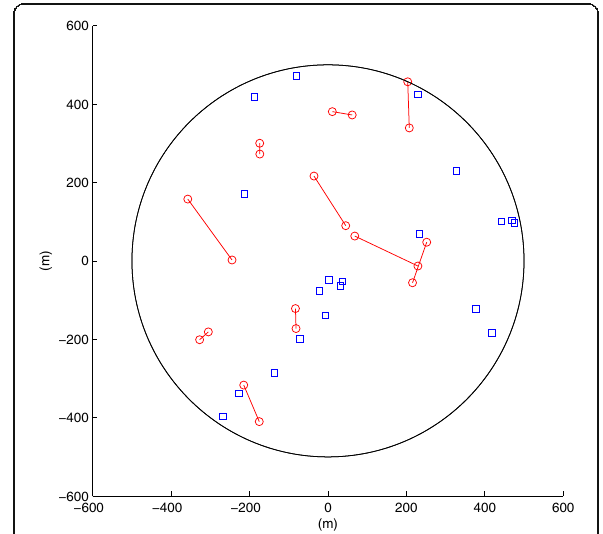
Fig. 4 An example of CU and D2D pair distribution in the